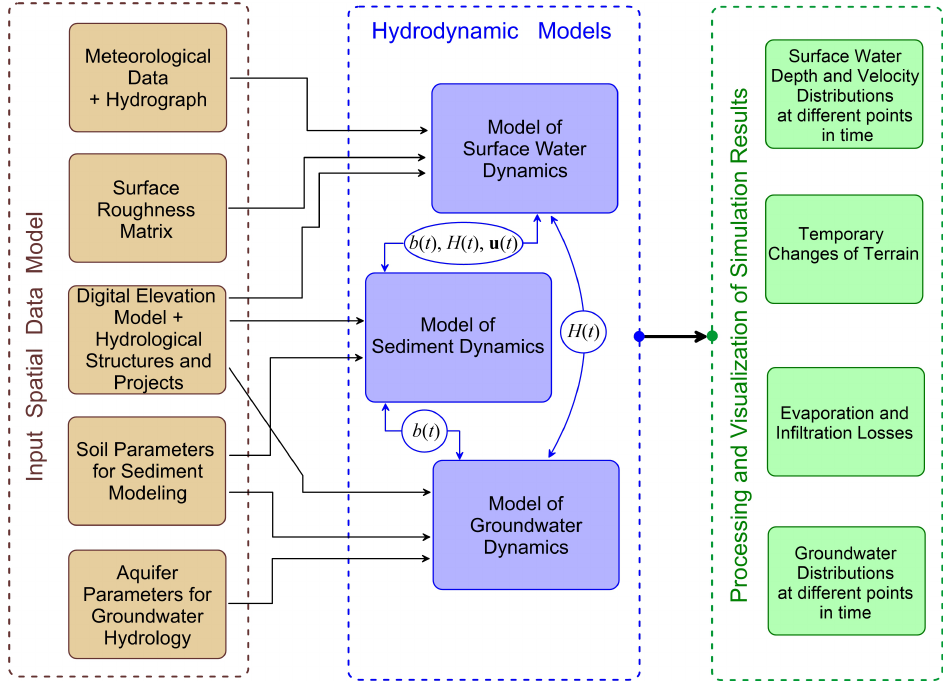
Figure 6. The main components of the computational model of the hydrological